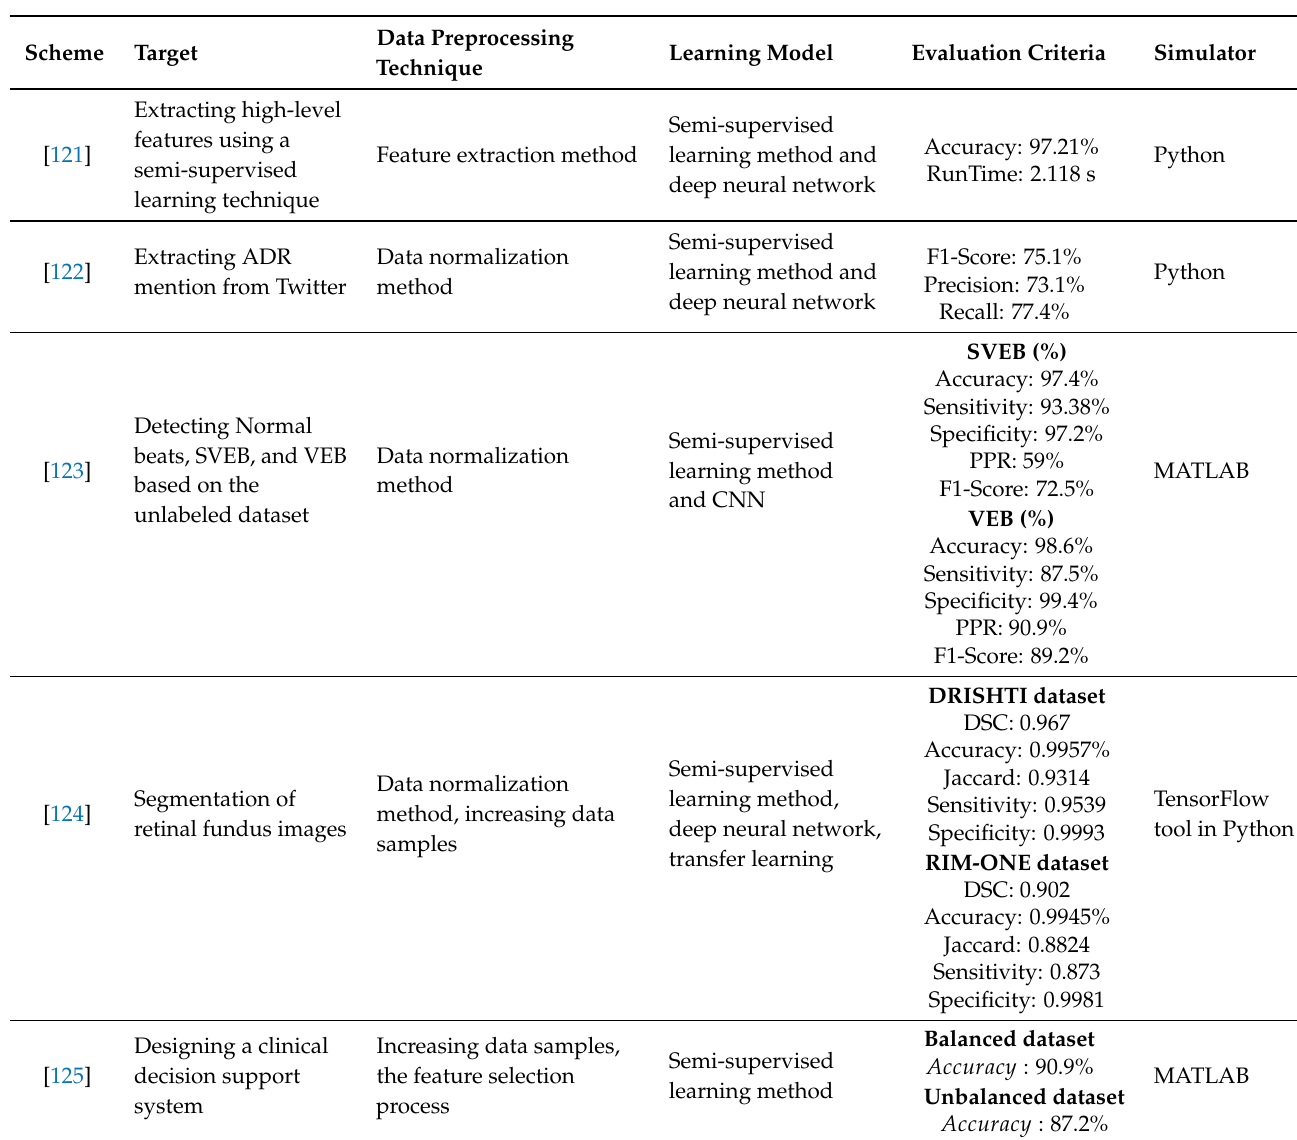
Table 12. The most important characteristics of semi-supervised learning-based